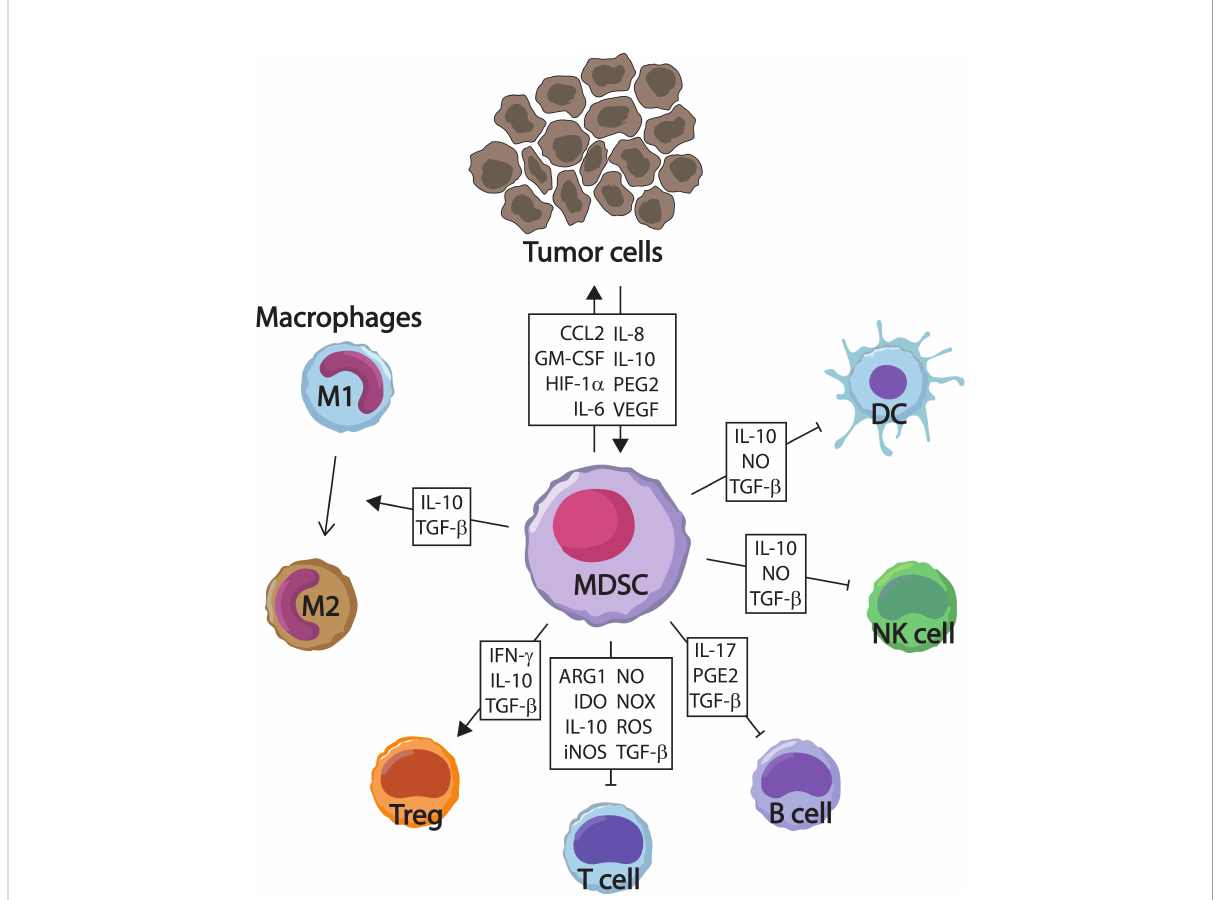
FIGURE 1 Immunosuppressive role of myeloid-derived suppressor cells (MDSC). MDSC exert their function by promoting the development and expansion of suppressor cells such as M2-macrophages and regulatory T cells (Treg), and inhibiting cell populations that participate in immune responses against the tumor, including dendritic cells (DC), T cells, B cells, and natural killer (NK) cells. Arg, arginase; CCL2, C-C motif ligand 2; GM-CSF, granulocyte/monocyte-colony stimulating factor; HIF, hypoxia-inducible factor; IDO, indoleamine 2,3-dioxygenase; IFN, interferon; IL, interleukin; iNOS, inducible nitric oxide synthase; NO, nitric oxide; NOX, nicotinamide adenine dinucleotide phosphate (NADPH) oxidase; PGE2, prostaglandin E2; ROS, reactive oxygen species; TGF, transforming growth factor; VEGF, vascular endothelial growth